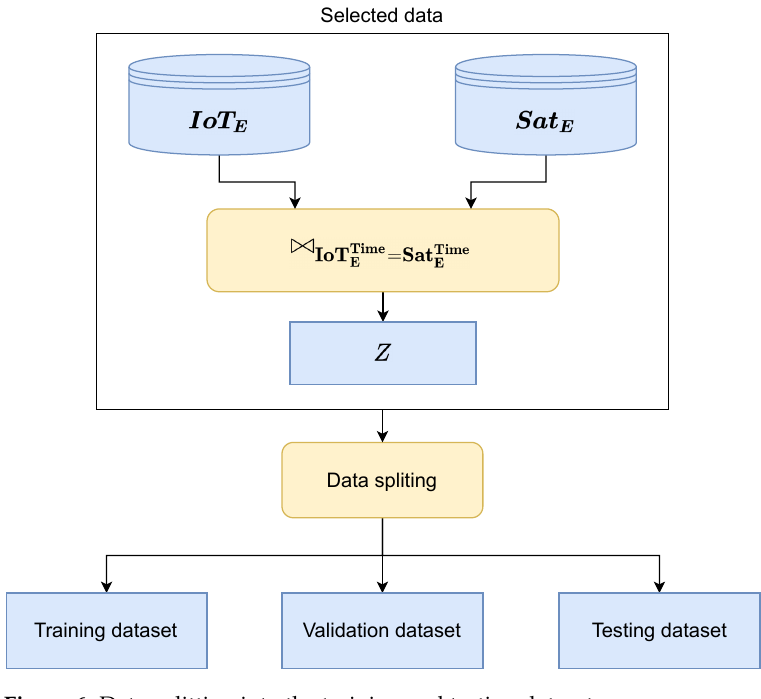
Figure 6. Data splitting into the training and testing datasets.